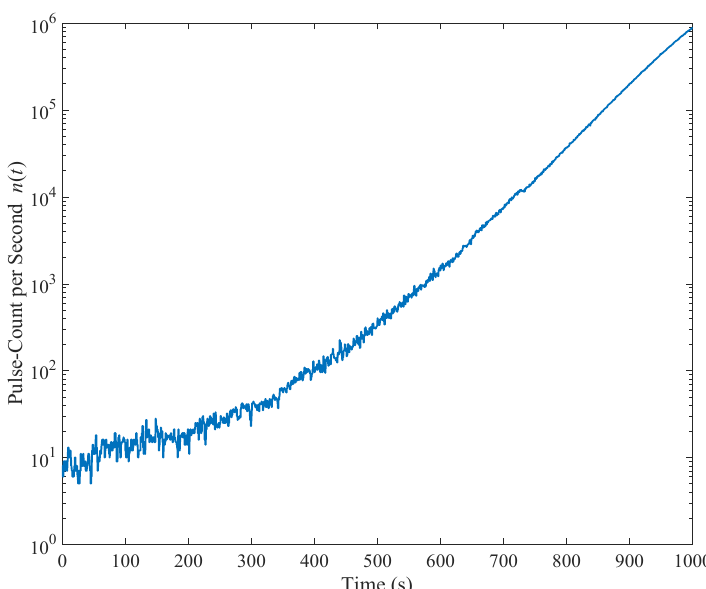
Figure 2. Practical measured pulse count per second.